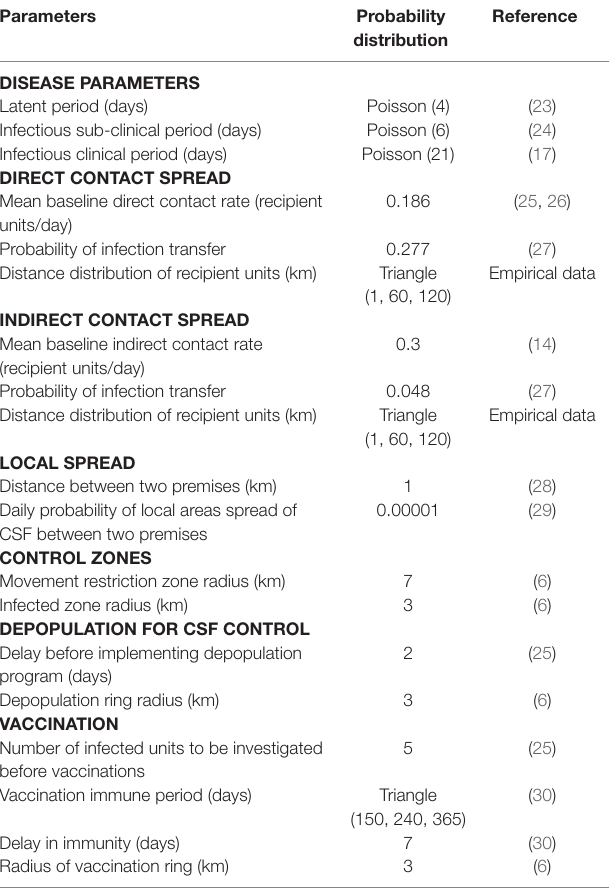
TaBle 4 | Premises-level model input parameters and the probability distributions used for the simulation of classical swine fever spread in indiana, United